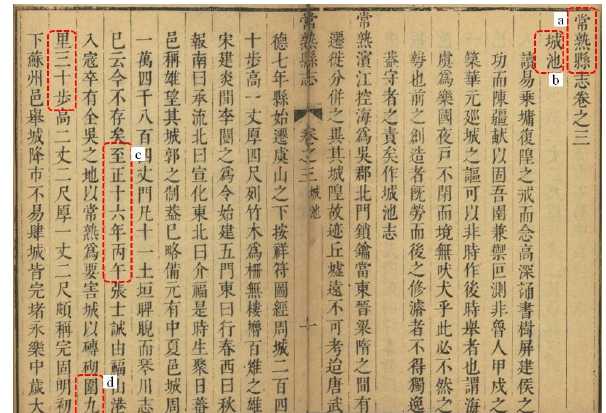
Figure 2. The image of the record of the city wall in a local chron- icle of the 17th century ( Kang-Xi Changshu county’s Chronicle ). (a) City’s name: Changshu (Jiangsu Province). (b) Chapter name: city wall and moat. (c) Year the city wall was built: the 16th year of Zhizheng in the Yuan Dynasty (1356CE). (d) The perimeter of the wall: around 4.6km (actual about